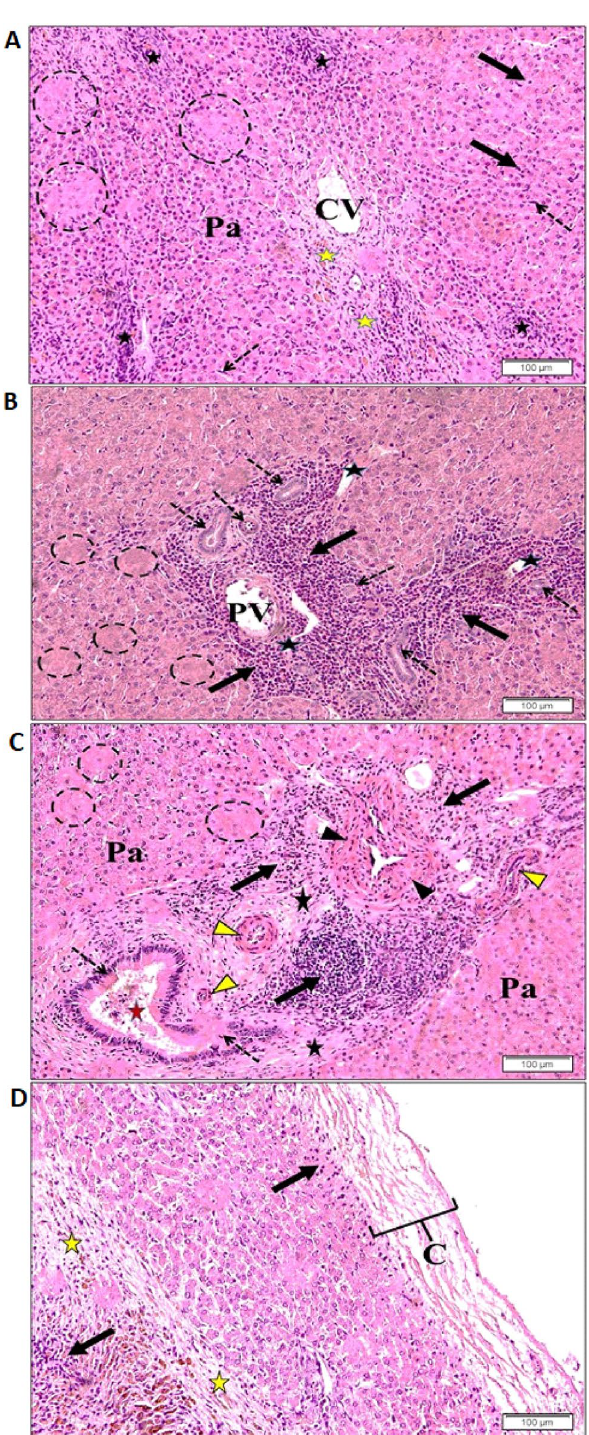
Figure 5. Light microscopic photographs of infected sheep liver stained with H&E. ( A ) Central vein (CV) region with disturbed parenchyma cells (Pa), focal lymphocytic infiltration (yellow stars), elongated endothelial cells (dotted arrows), enlarged Kupffer cells (arrow) and patches of lysed (necrotic) hepatocytes (dotted circle); ( B ) portal vein (PV) of the portal region with eosinophil and lymphocyte infiltration (arrows), the proliferation of bile ducts (dotted arrows) and lymphatic vessels (black stars). The adjacent liver parenchyma with patches of degenerating and lysed (necrotic) hepatocytes (dotted circles); ( C ) eosinophil infiltration, lymphocytes, and proliferating fibroblast (arrow), thickening of the hepatic artery (arrow heads) and arteriolar walls (yellow arrow heads), fibrosis (black stars), hyperplasia of bile ducts epithelium (dotted arrows) with damaged columnar epithelial and detached lining into the lumen (red star). The adjacent liver parenchyma (Pa) showed hepatocellular foci and lysis (dotted circles); ( D ) Glisson’s thickened capsule (C), parenchyma fibrosis (yellow star) with sub capsular infiltrated inflammatory cells